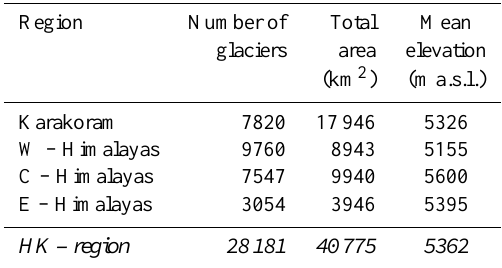
Table 1. Number, area, and mean elevation of glaciers as derived with the void-filled SRTM DEM from CGIAR; see also Supplement in Bolch et al. (2012).